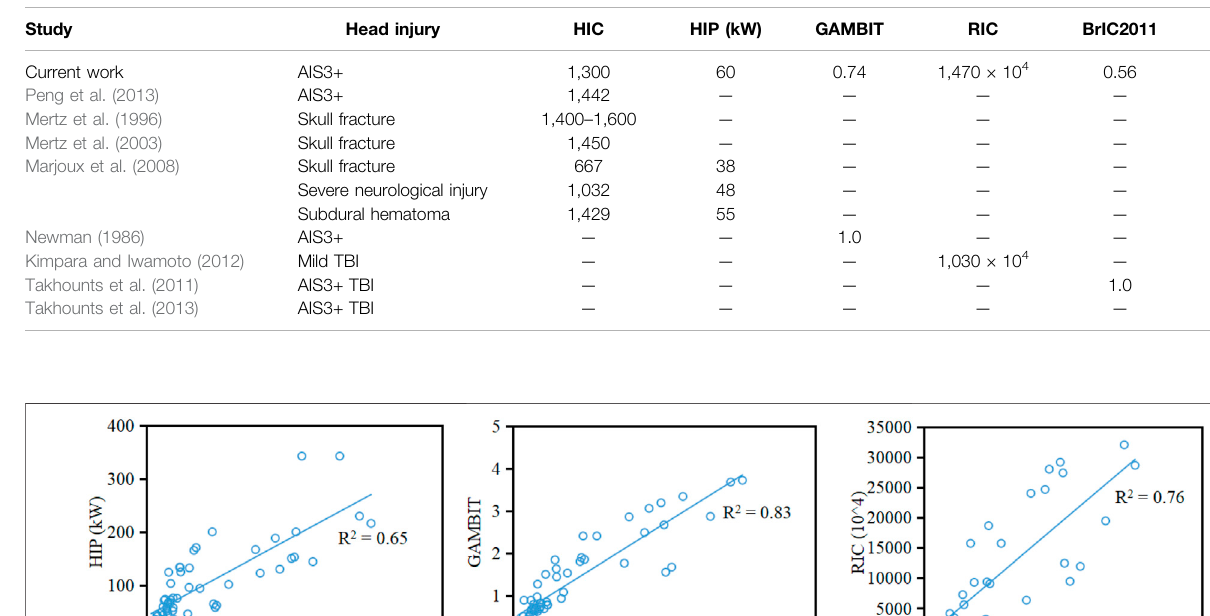
TABLE 2 | Thresholds for 50% risk of head injuries from different studies.